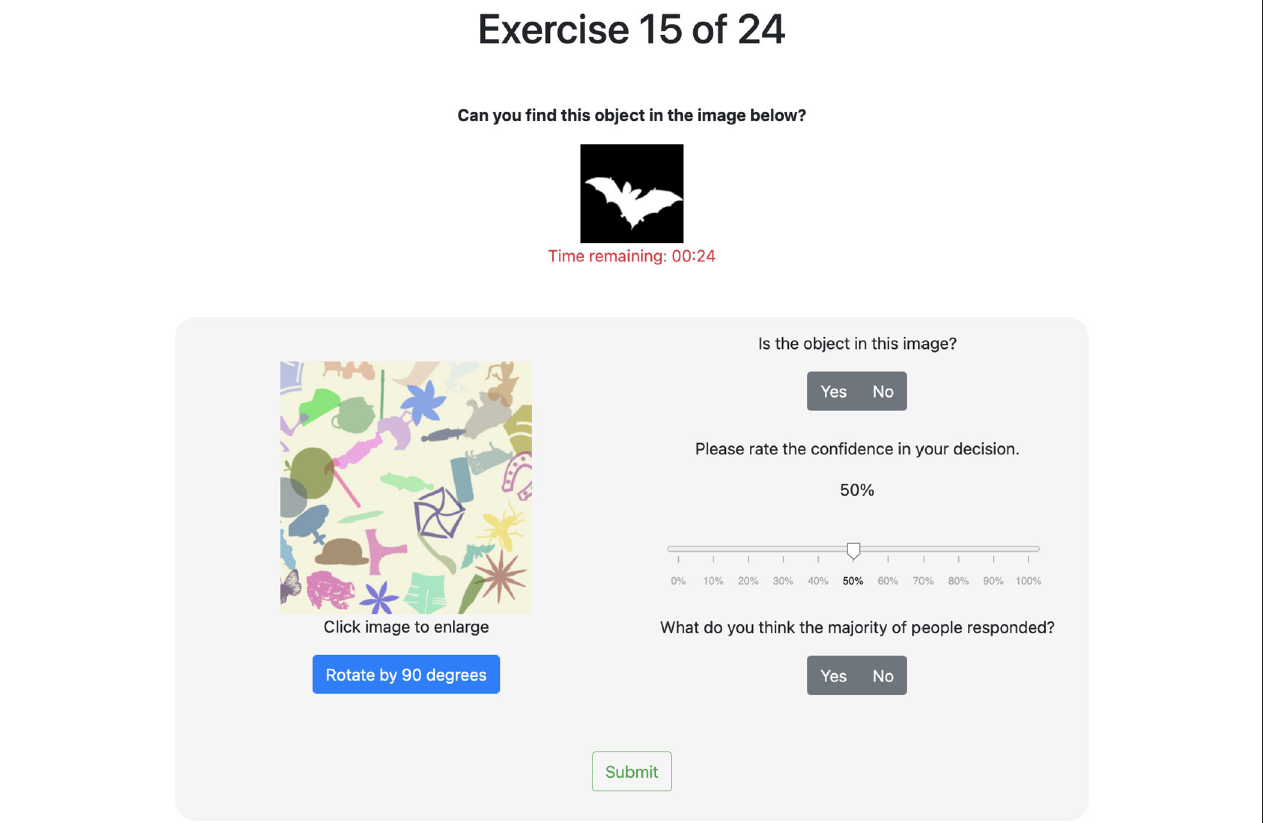
FIGURE 2 | Image classification task UI for balanced dataset—image contains bat (lower